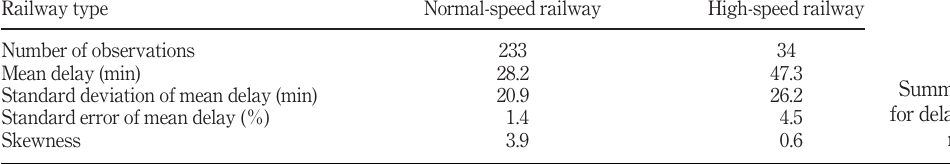
Table 5. Summary